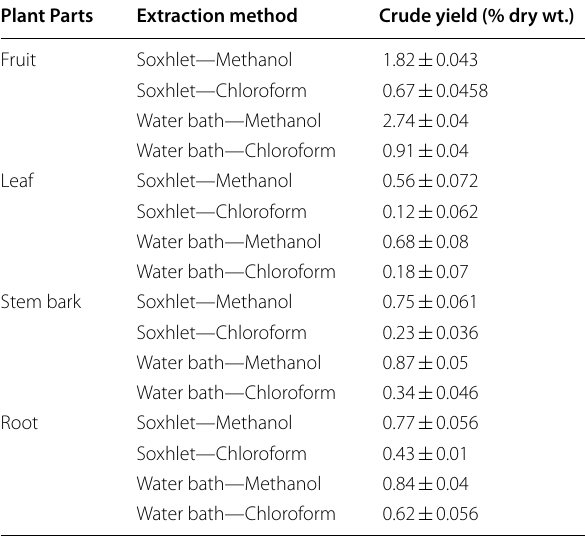
NB-Data are expressed as mean